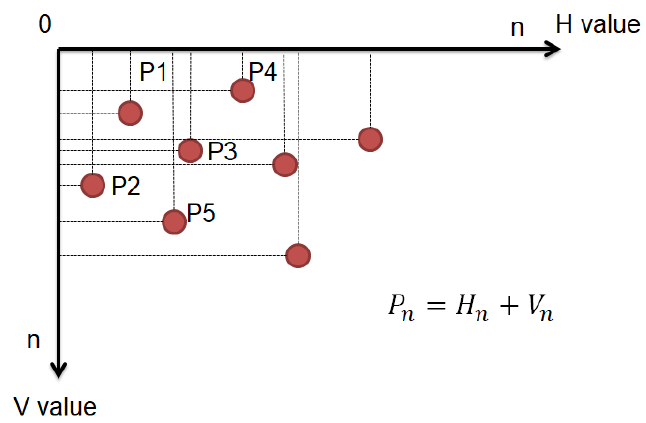
Figure 22. Tomato picking priority diagram.